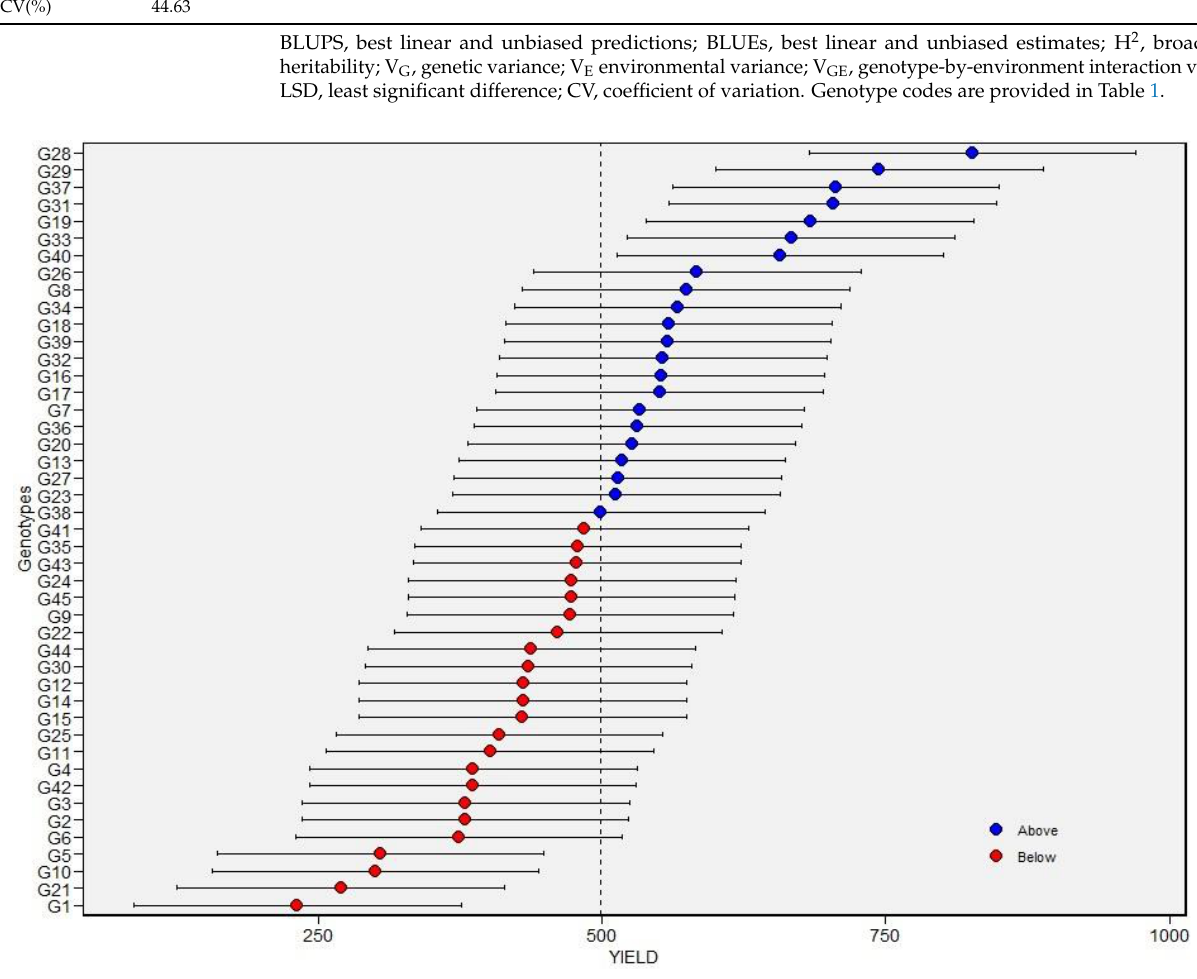
Figure 3. Best linear unbiased predictions (BLUPs) values of 45 tepary bean accessions for seed yield. Blue and red circles indicate the genotypes that had BLUPs above and below of BLUPs grand mean, respectively. Horizontal error bars indicate the 95% confidence interval of the prediction line with a two-tailed t -test. See Table 1 for genotype codes.